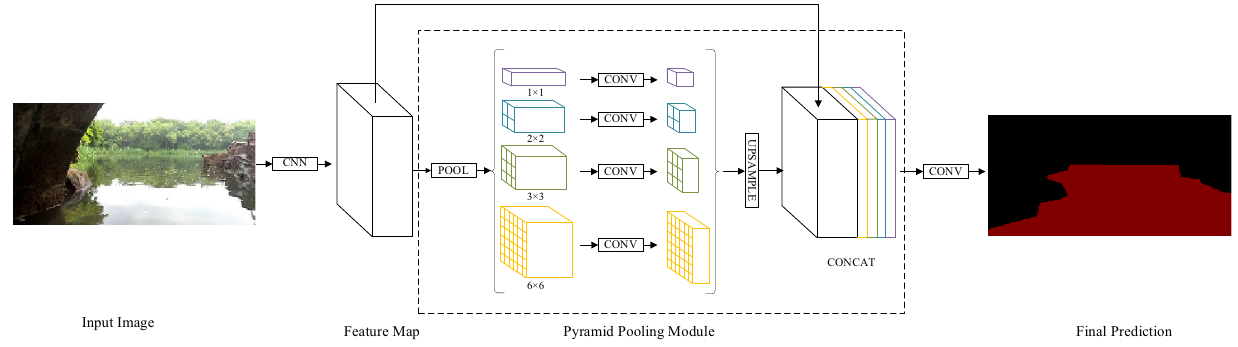
Fig. 1 PSPNet network